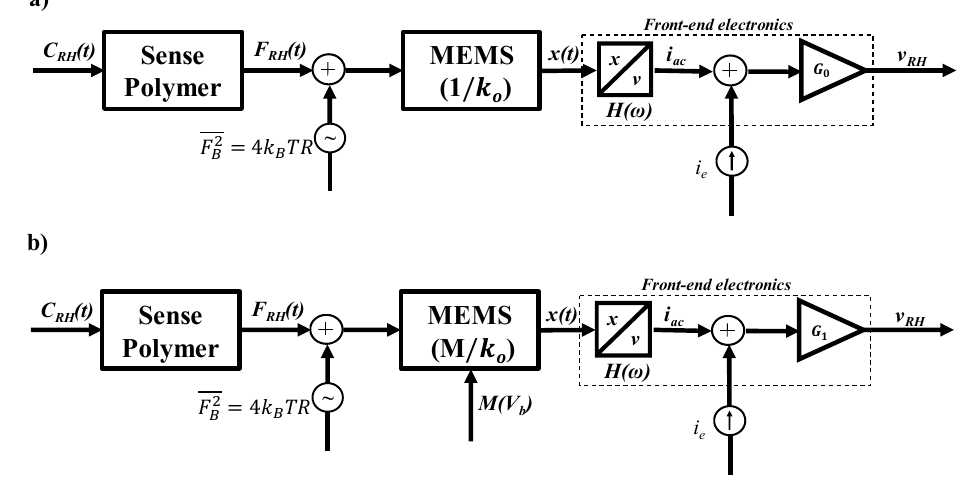
Figure 3. ( a ) Schematic of the sensor system at zero bias with default spring constant k o ( b ) with parametric amplification (near-Brownian noise is limited).